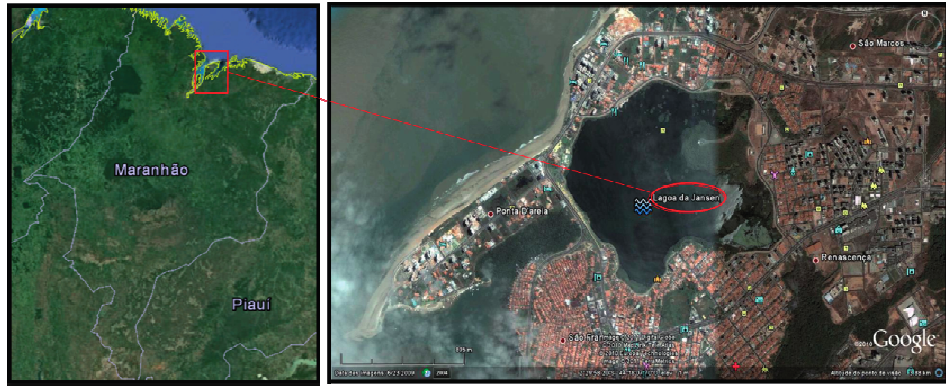
Figure 1. Lagoon Jansen, São Luís, Maranhão, Brazil. Source: Google